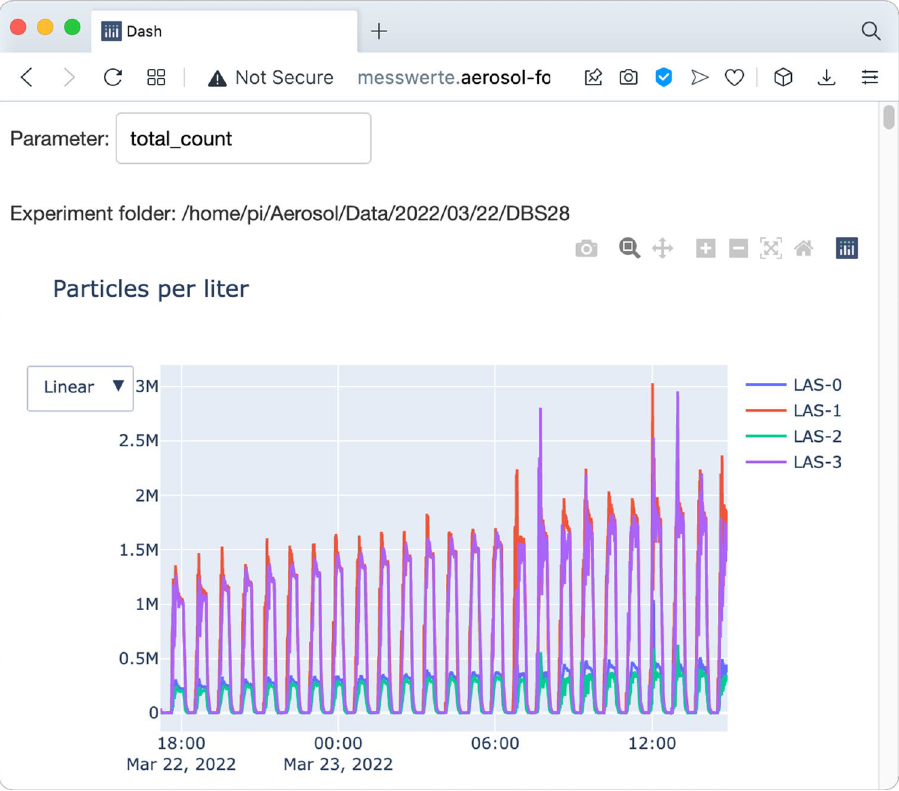
of a certain countermeasure and ensure the experiment’s